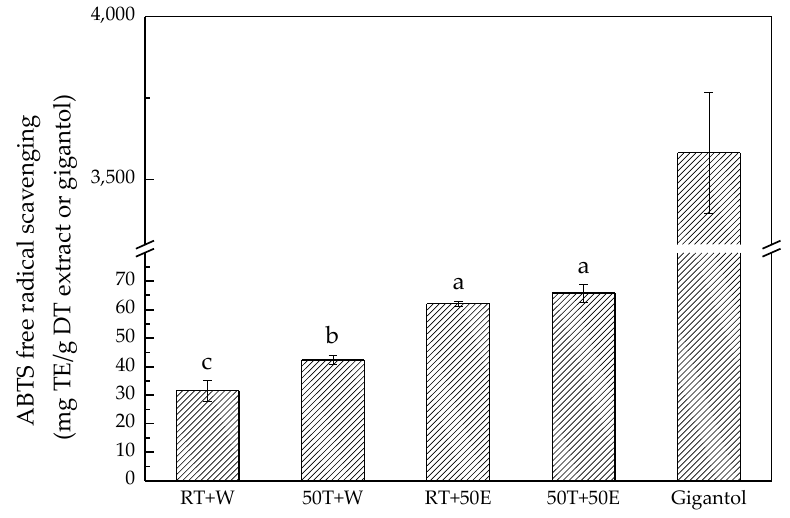
Figure 5. 2,2′-Azino-bis(3-Ethylbenzothiazoline-6-Sulphonic acid) (ABTS) free-radical scavenging for the four extracts and gigantol. Treatment means with the same letter are not significantly different.